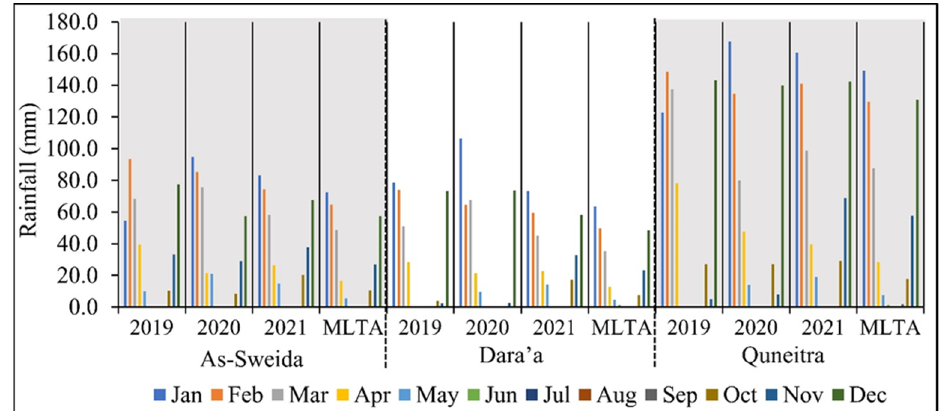
Figure 7. Statistics of the rainfall in three agroclimatic stations in the Syrian part of the Yarmouk River Basin during 2019–2021. MLTA is the monthly long-term average during 1986–2021.